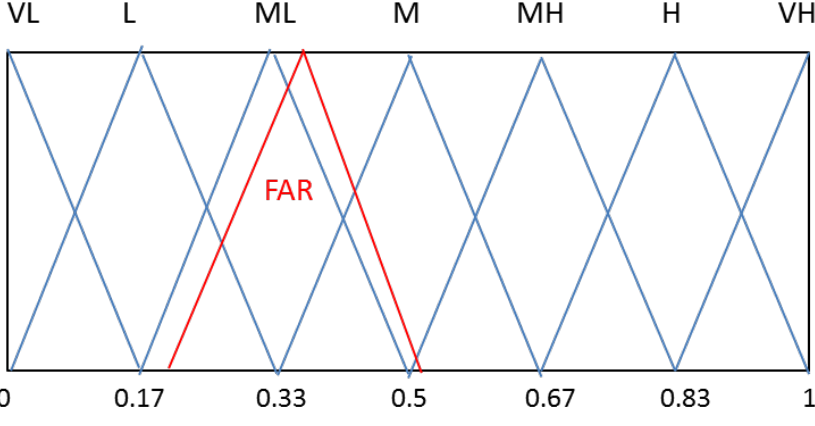
Figure 4. Used membership function and labels.